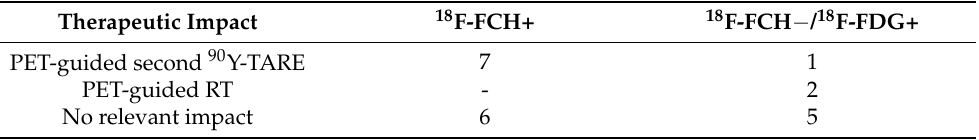
Table 3. Impact of 18 F-FCH/ 18 F-FDG PET/CT on patient management.